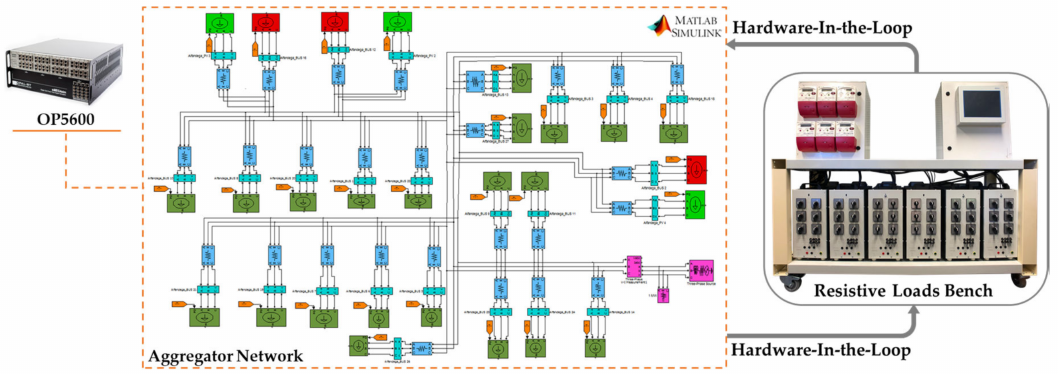
Figure 6. Real-Time simulation model of aggregator integrated with HIL methodology.